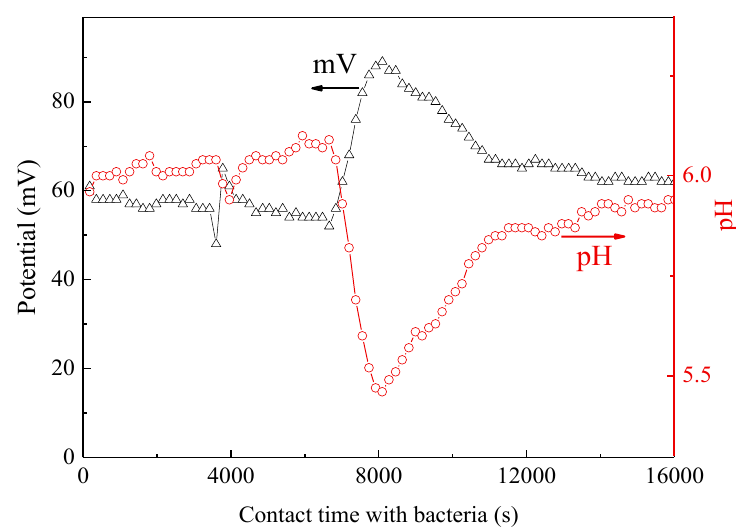
Figure 10. Evolution of the interfacial potential and local pH of an E. coli suspension in contact with Bi 2 WO 6 under low intensity light irradiation (48 mW/cm 2 ). Catalyst concentration 0.2 g/L.